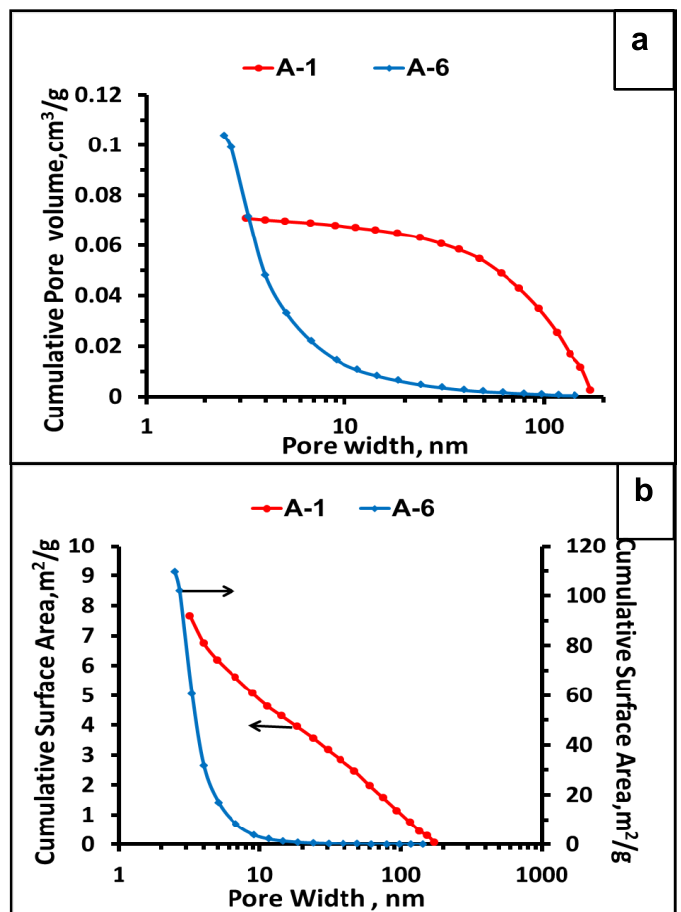
Figure 10 . Cumulative plots of the distribution of pore width for samples A-1 and A-6: ( a ) by pore volume, ( b ) by pore surface.